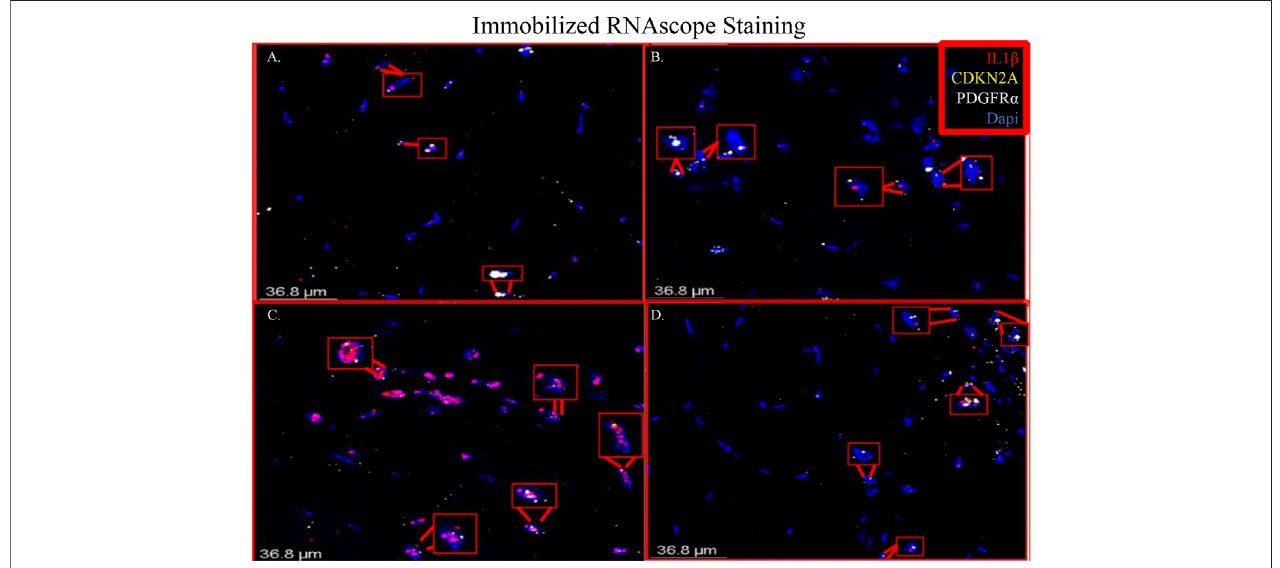
FIGURE 5 | Merged RNAscope images of immobilized muscle. The merged RNAscopeimages of immobilized muscle with probes for IL-1 β (red), Cdkn2a (yellow) andPDGFR α (white)stainingareshown.Stainingshowsco-localizationofPDGFR α withbothIL-1 β andCdkn2aasindicatedwiththeredboxes.PanelAcorrespondsto row one of Supplementary Figure S2 , Panel B to row 2, Panel C to row 3 and Panel D to row 4.